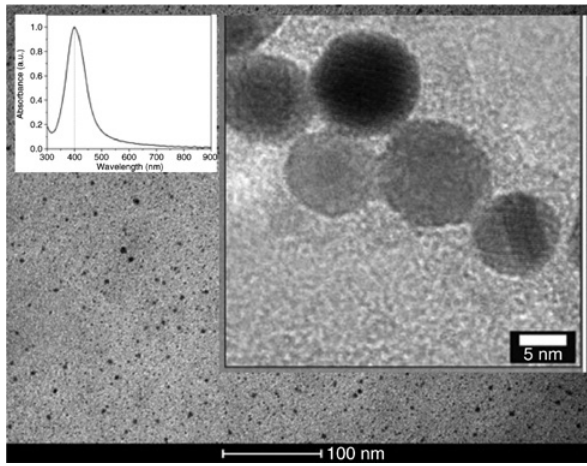
Figure 1: NSF characterization.